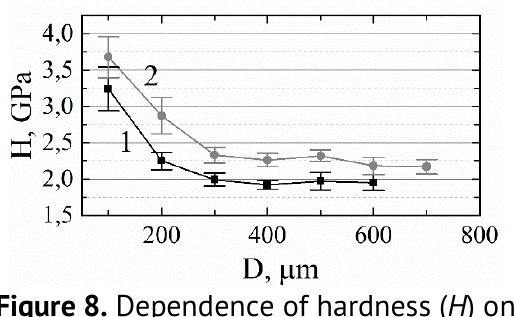
Figure 8. Dependence of hardness ( H ) on the distance ( D ) to the “metal/metal” friction surface. Curve 1 - friction for 1 hour; curve 2 - 10 hours.